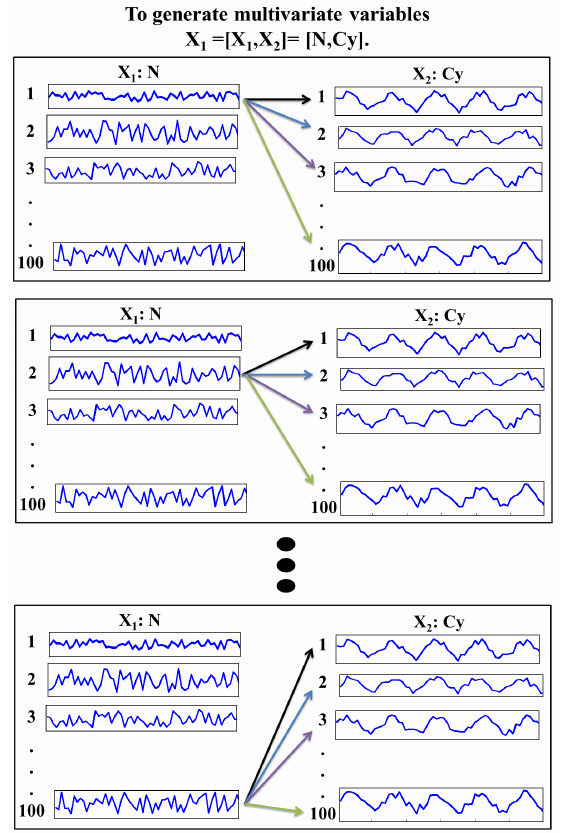
Figure 3. An example of the generation of the class of multivariate variable X 1 consisting of elements X 1 with Natural pattern and X 2 with Cycle pattern is shown. In the database, there are 100 samples that have the normal pattern and 100 samples that show cyclic pattern. Then, the first variable that has the normal pattern is combined with each of the 100 samples that expose the cyclic pattern; in this way, the procedure is repeated until the 10,000 multivariate samples of type X 1 are formed. The same procedure is performed to generate 10,000 multivariate samples for the 36 classes or types of multivariate variables X as shown in Table